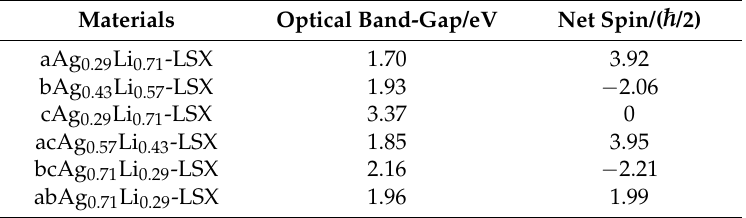
Table 2. The calculated values of electronic band-gaps and net spins for Ag-exchange Li-LSX. Materials